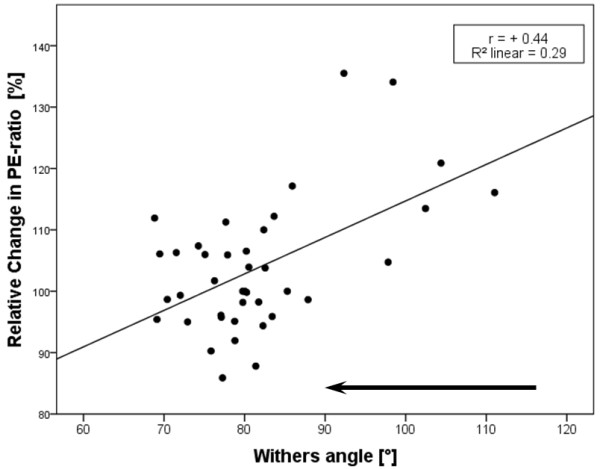
Correlation between the WA and the relative change in PE-ratio. The arrow (above the x-axis) points in the direction of increasing head-neck flexion (n = 40).